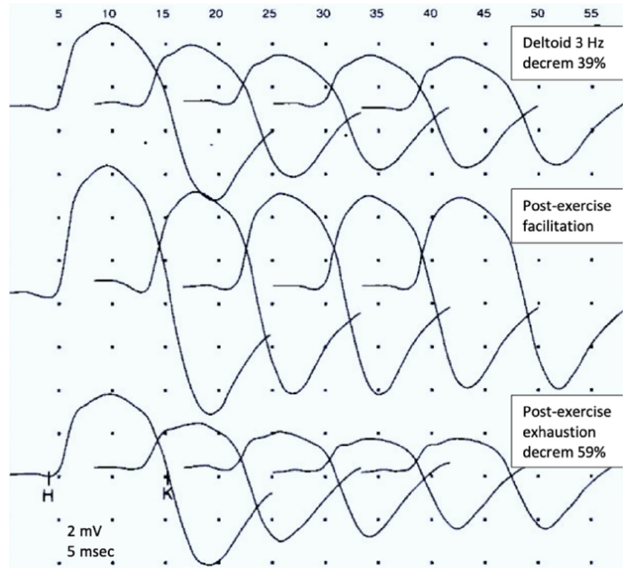
Figure 5. Postexercise facilitation and exhaustion.